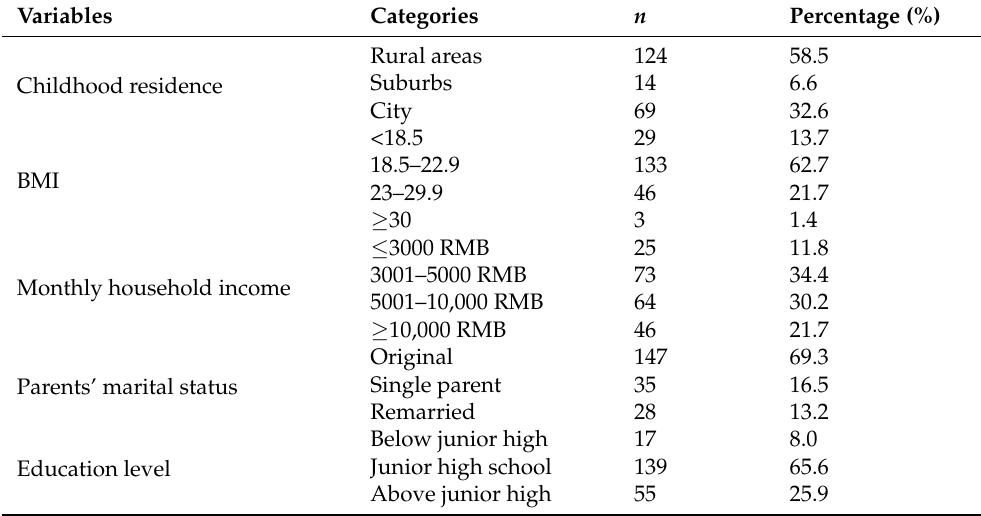
Table 1. Demographic characteristics of the